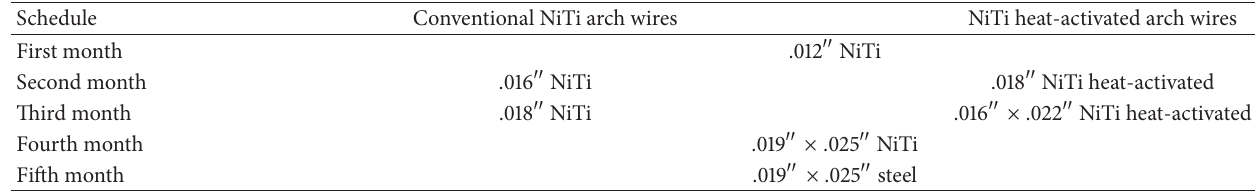
Table 1: Arch wires (inches) used in each clinical